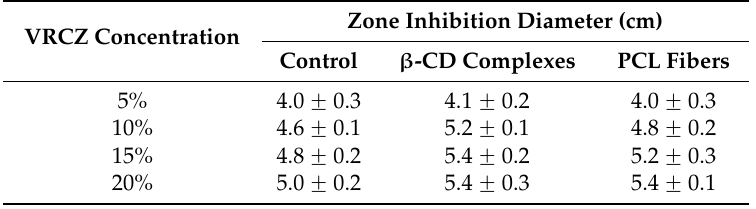
Table 3. Results of the formulation zone inhibition. Table3. Results of the formulation zone inhibition.